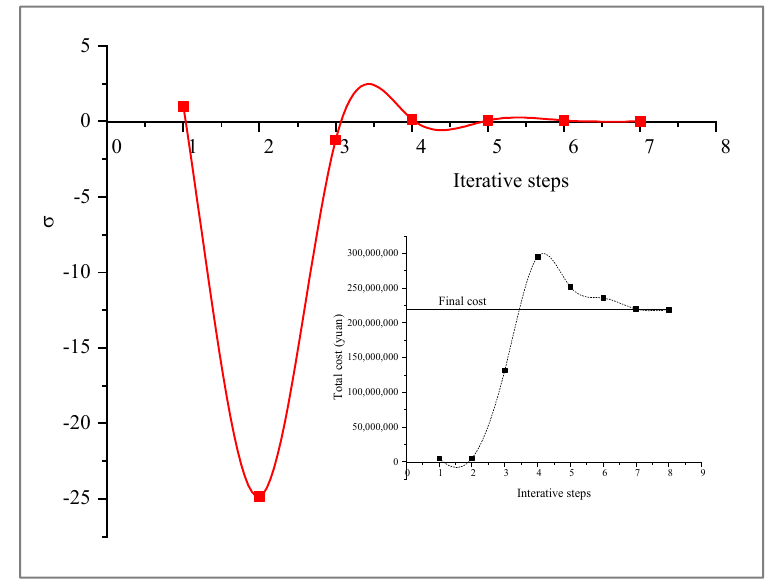
Figure 7. Curve of σ (cid:3046) varying with iteration steps in the solution process.